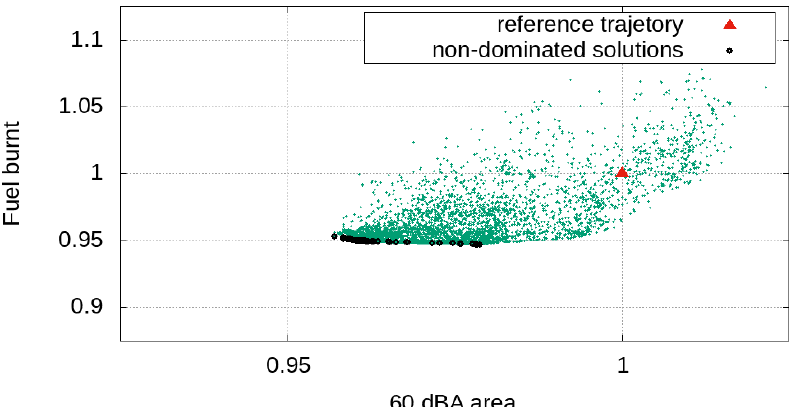
Figure 10. Takeoff manoeuvre for the twin-aisle aircraft: normalised DPSO solutions with reference trajectory and approximated Pareto